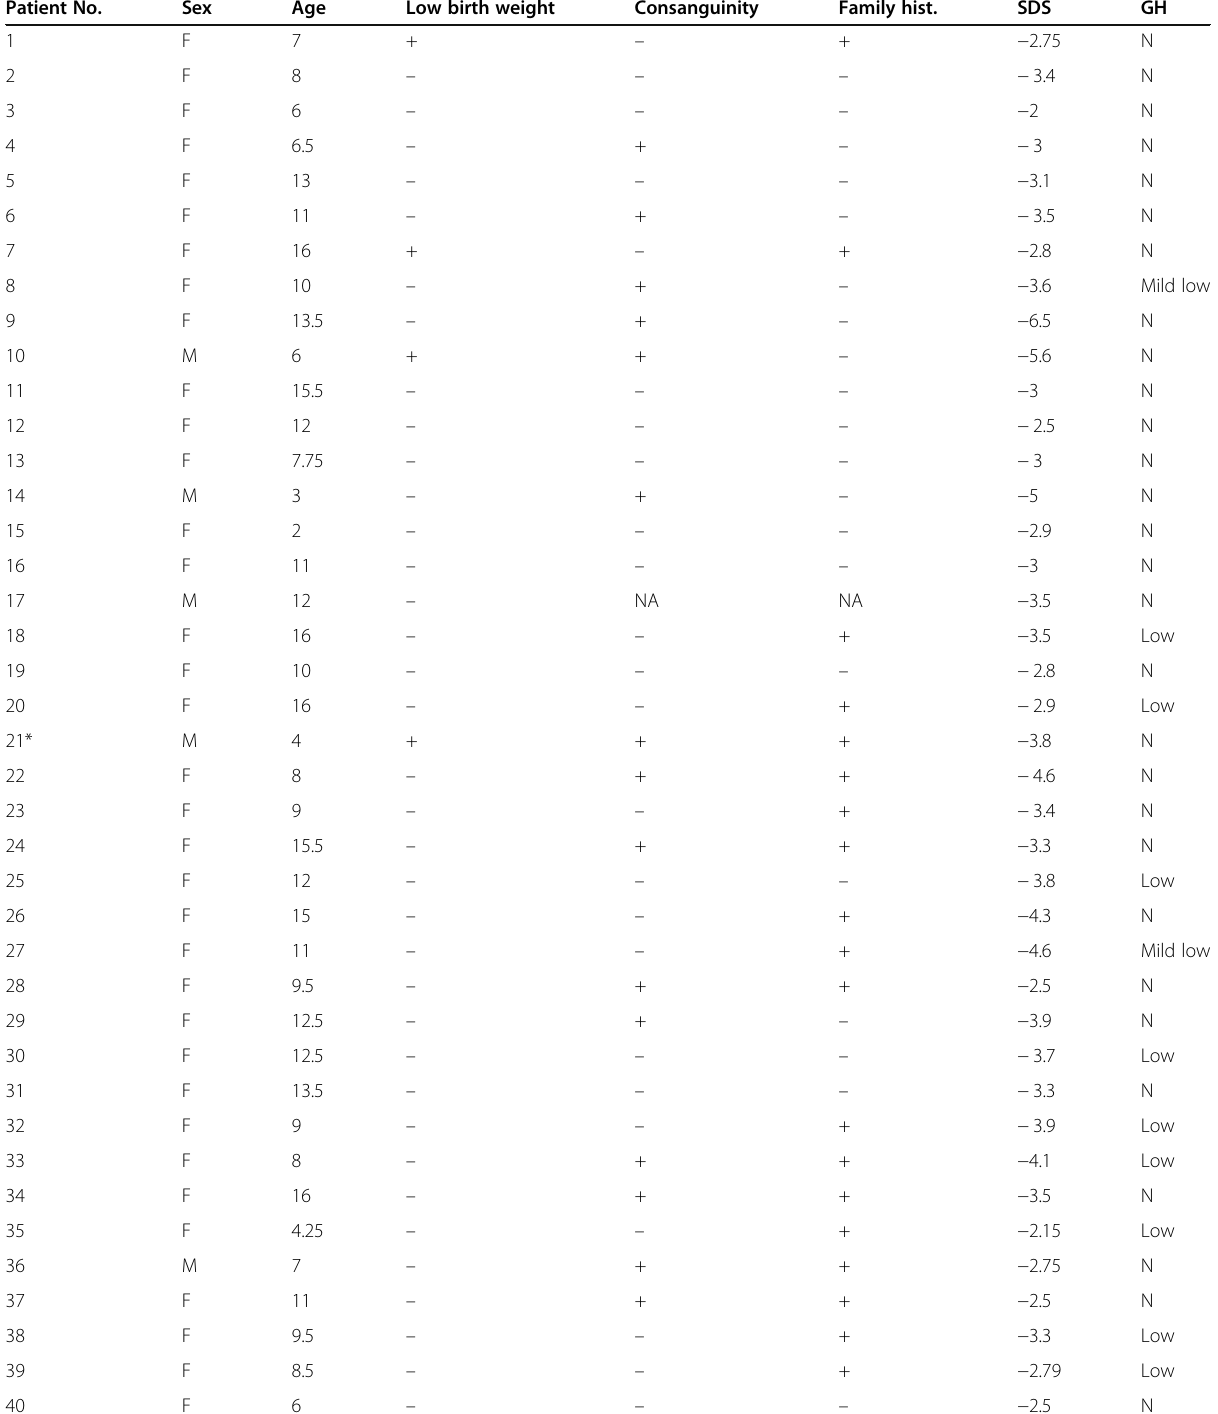
Table 1 clinical data and growth hormone levels of studied patients Patient